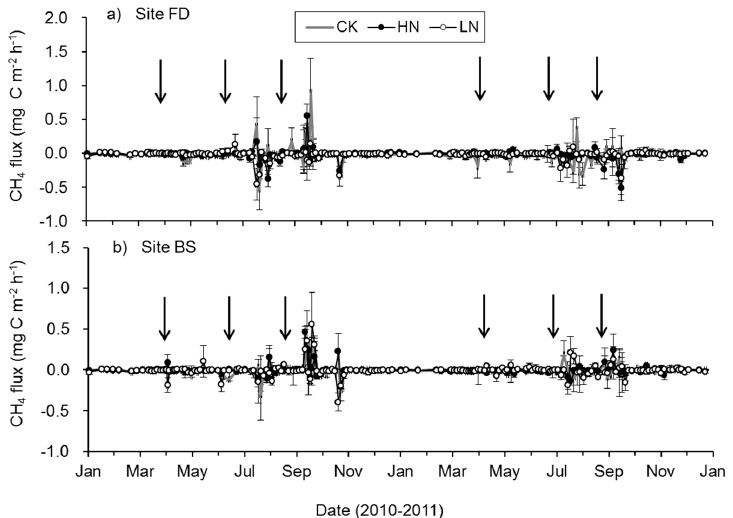
Figure 6. Seasonal variations in CH 4 flux across the sampling sites and treatments during 2010–2011. FD, fertilized ditch. BS, bare soil with none ferltilizers. ( a ) Fertilizer ditches; ( b ) Bare soil; Data points indicate the mean of the three replicates; error bars indicate the standard error (SE). Black arrows indicate nitrogen fertilizer applications.